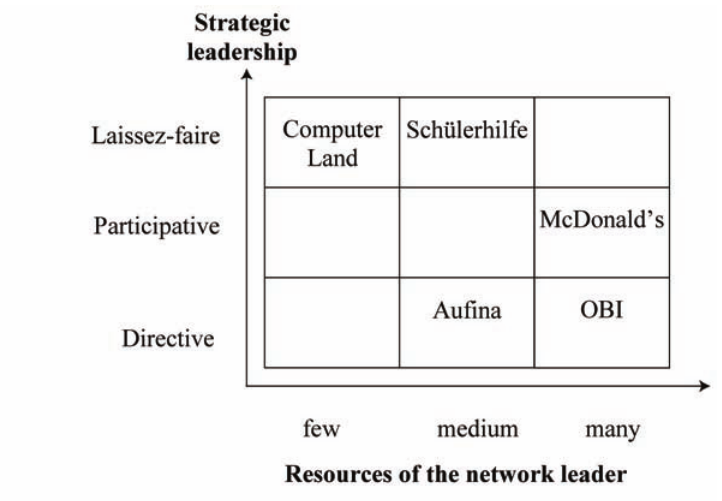
Fig. 3. Two-dimensional levels of franchise system’s integrity (based on Sydow